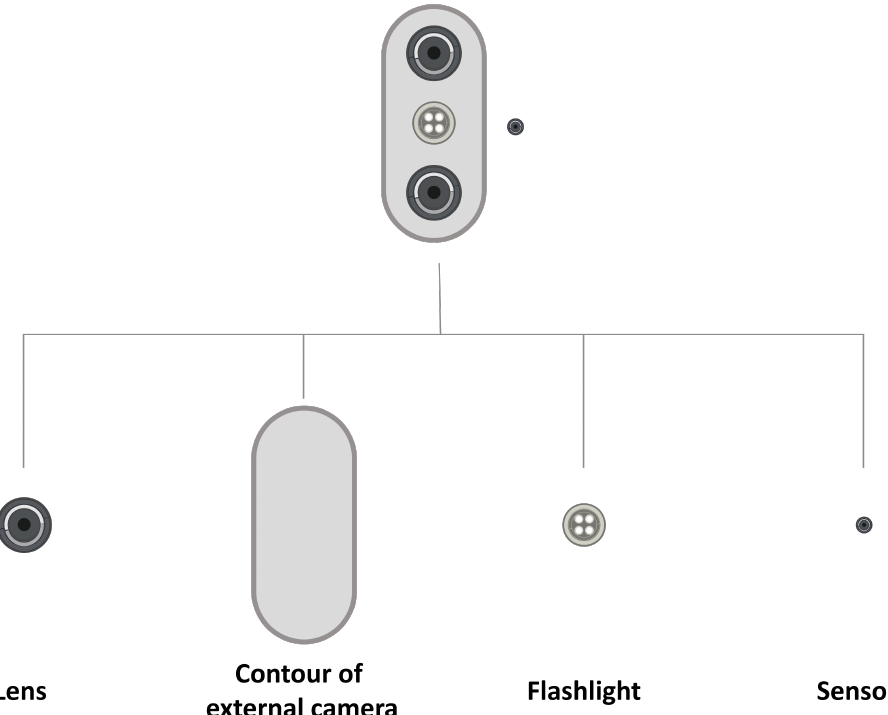
Figure 2. The formation of smartphone rear